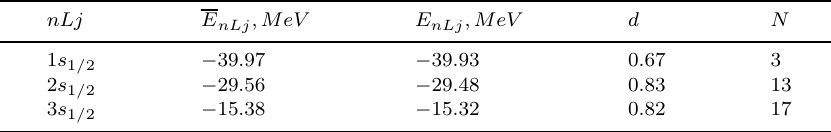
Table 2. The energy levels E nLj and E nLj of neutrons of nucleus 197 Pb. nLj E nLj ,MeV E nLj ,MeV d N 1 s 1 / 2 − 39 . 97 − 39 . 93 0.67 3 2 s 1 / 2 − 29 . 56 − 29 . 48 0.83 13 3 s 1 / 2 − 15 . 38 − 15 . 32 0.82